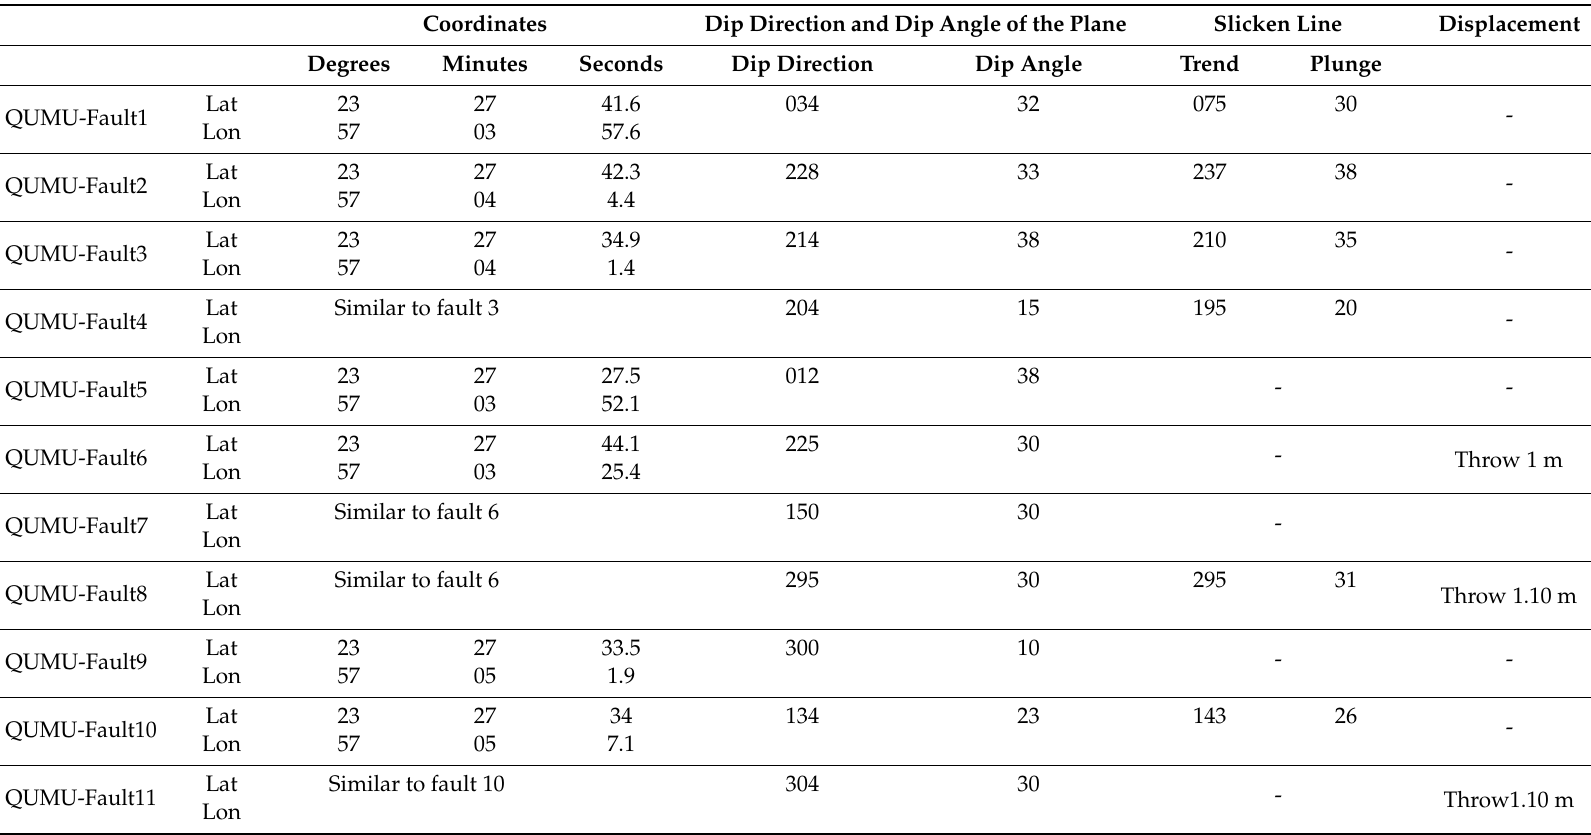
Table 1. Structural data for the investigated Quaternary faults. The fault numbers correspond to the stop numbers in Figure